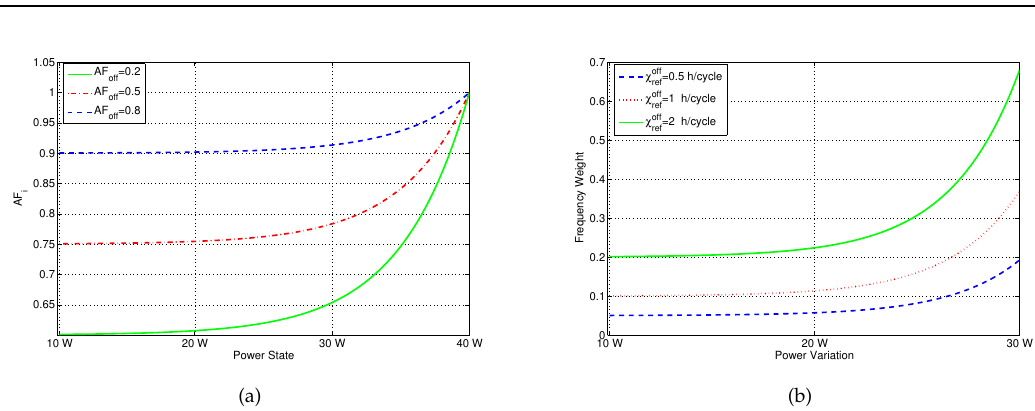
Figure 2. Exponential model: AF i values and frequency weight values. ( a ) AF i values; ( b ) frequency weight